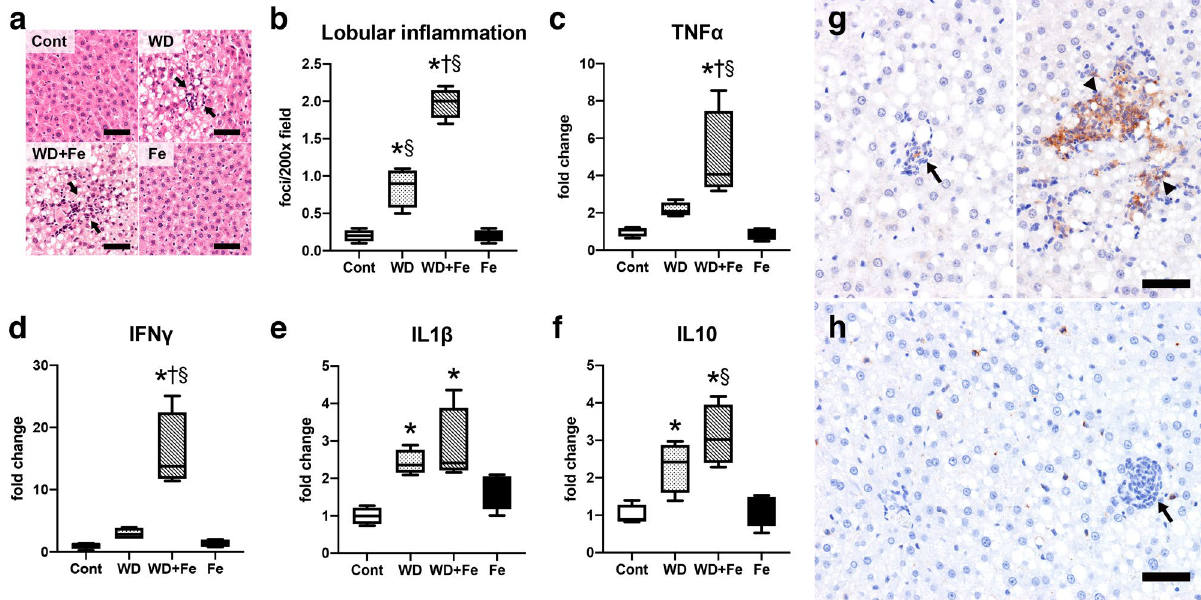
Figure 6. ( a ) Histological images representing microgranuloma (arrows) with mononuclear cell infiltrate in the fatty liver of WD and WD + Fe group. Inflammation is absent to minimal in Cont and Fe groups. ( b ) The number of inflammatory foci in the hepatic lobule at weeks 26. Hepatic expression of ( c ) TNFα, ( d ) IFNγ, ( e ) IL1β, and ( f ) IL10 mRNA at week 26. Data were normalized to 18S rRNA and expressed as fold change from control. Data are presented as box and whiskers (n = 4/group). * P < 0.05 versus Cont, † P < 0.05 versus WD, and § P < 0.05 versus Fe by one-way ANOVA followed by Tukey’s multiple comparison. Images of IHC for ( g ) iNOS and ( h ) CD206 in WD + Fe group at week 26. Arrows indicate microgranulomas while arrowheads indicate large inflammatory foci. Bar; 50 μm.